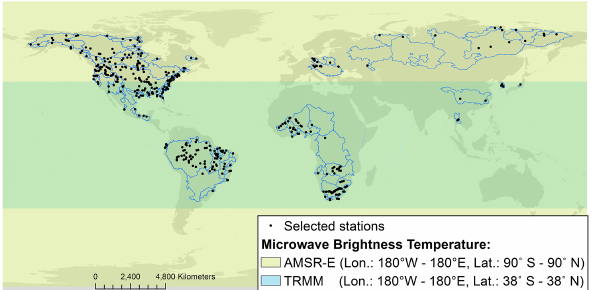
Figure 1. Location of selected stations (398) and corresponding river basins (109). TRMM and AMSR-E brightness temperature product extents are also